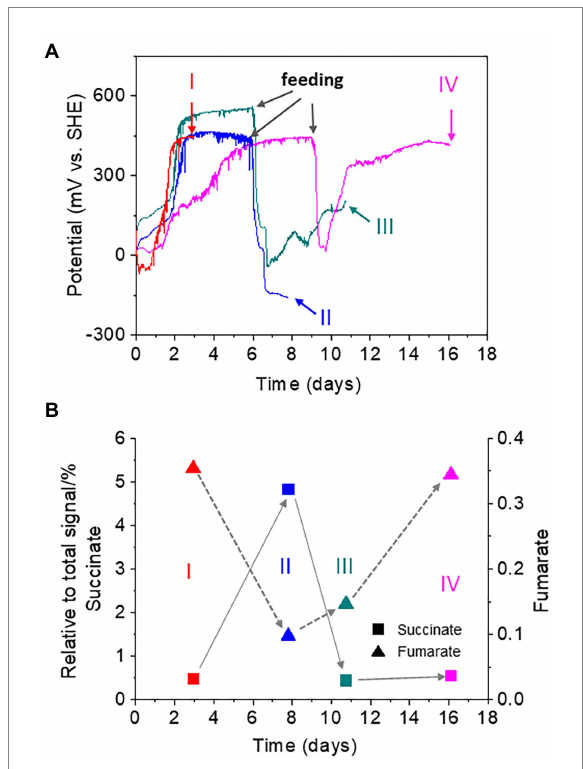
FIGURE 4 (A) Time courses of open circuit potential measurements for the sediment containing oligochaetes and sediment microorganisms. Forty oligochaetes specimens were collected at 4, 8, 11, and 16 h for nuclear magnetic resonance (NMR) analysis. Red line: sample I at a high redox potential before feeding; light blue line: sample II at a low redox potential after feeding; green line: sample III at the mid-redox potential during recovering; and magenta line: sample IV at a high redox potential after recovery. (B) Changes in the relative intensity of the NMR signals for succinate (squares) and fumarate